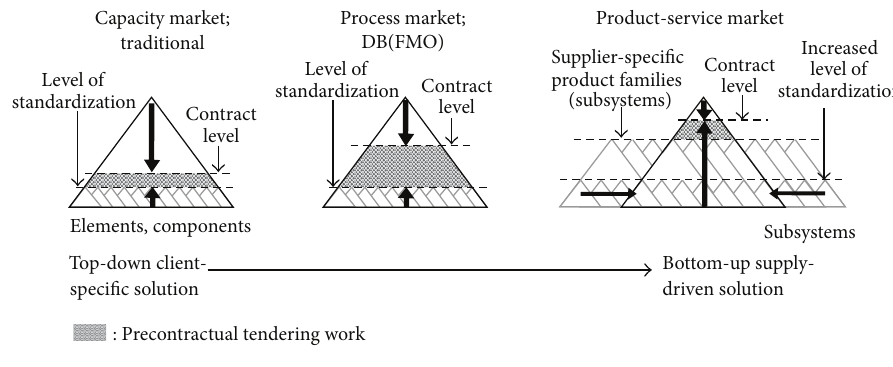
Figure 1: Proposed transition of the construction industry